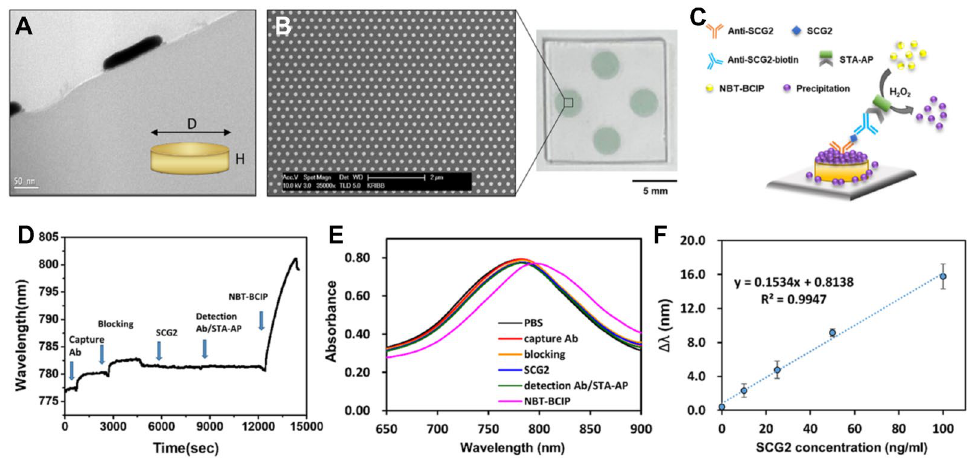
Figure 1. Nanoplasmonic immunosensor for detection of serum SCG2. ( A ) Transmission electron microscope (TEM) image of a gold nanodot. D (diameter): 150 nm, H (height) 20 nm. ( B ) Scanning electron microscope (SEM) image of gold nanodot array (GNA) uniformly fabricated on a glass substrate. The GNA chip has a size of 13 mm × 13 mm. The size of the circle sensing region inside the chip is 3 mm in diameter. ( C ) A schematic representation of the nanoplasmonic immunosensor using enzyme catalytic precipitation reaction. STA-AP, streptavidin–alkaline phosphatase-conjugate. The real-time sensorgram ( D ) and LSPR spectral changes ( E ) of each step in the immunoassay for SCG2 (100 ng/mL). ( F ) Standard curve was prepared by plotting the ∆λ measured with varying concentration of SCG2 (from 0 to 100 ng/mL). The regression equation was y = 0.1534x + 0.8138 (R 2 = 0.9947) in the linear range. Each data point is the average of N = 3 individual measurements, and the error bars indicate standard